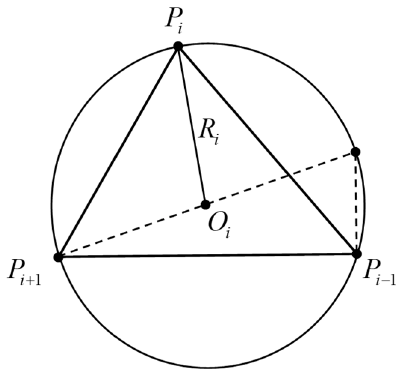
Figure 3. Curvature estimation of the center point.